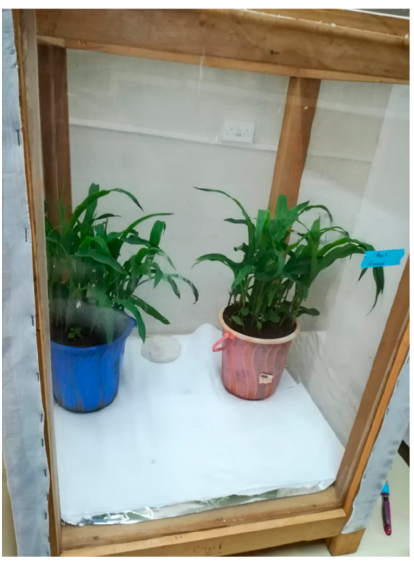
Figure 4. Two-choice experimental set-up with rabbit urine-treated and untreated potted maize plants for gravid female moths of the fall armyworm to lay eggs during the oviposition assay.